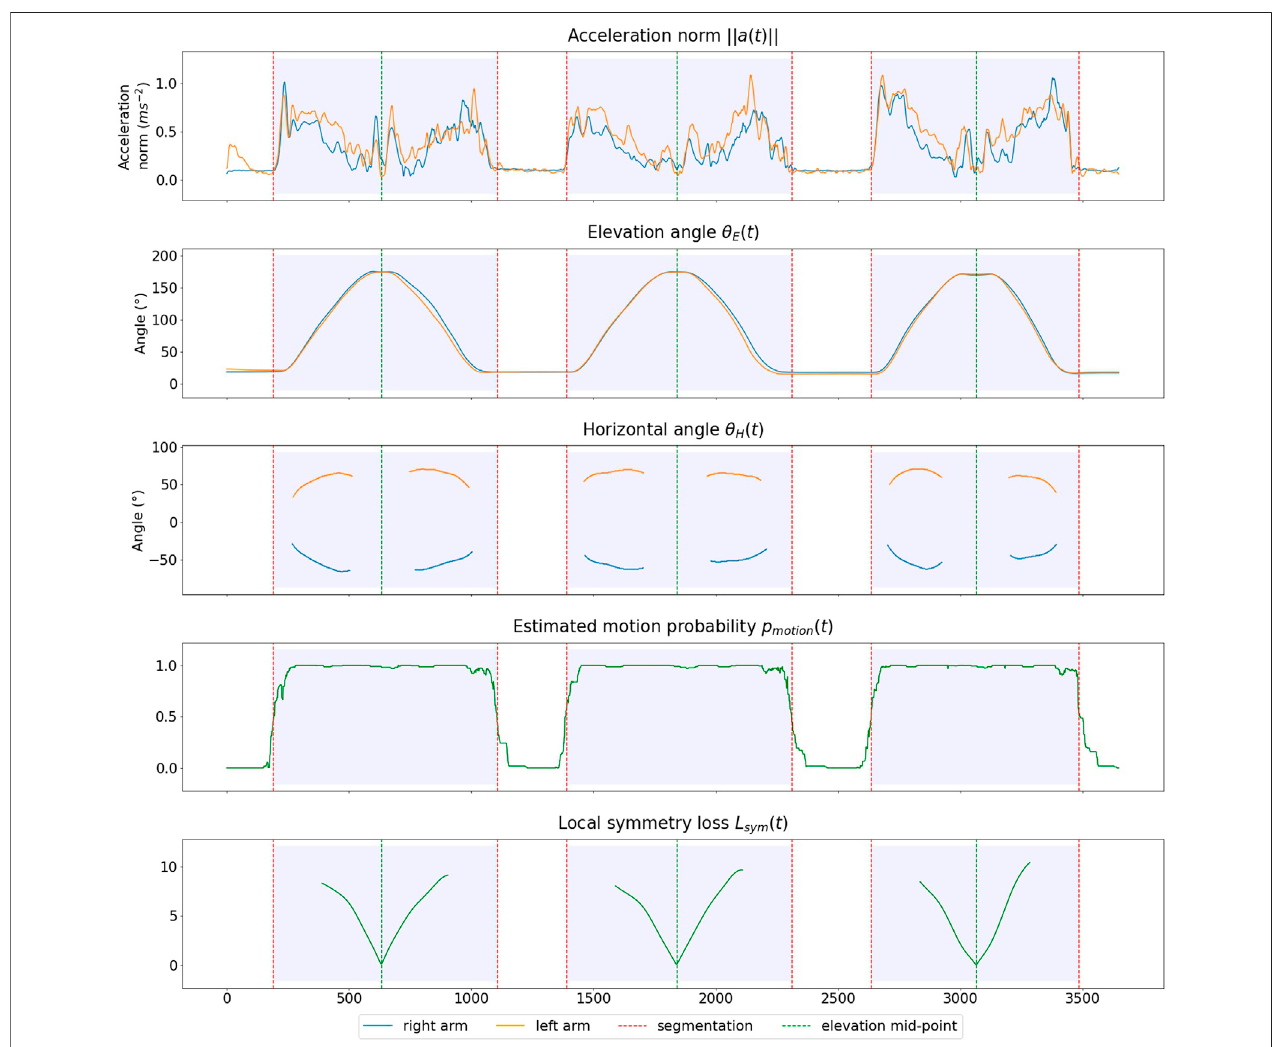
FIGURE 4 | Example of computed segmentation and midpoints for a participant performing scapular plane arm elevation.